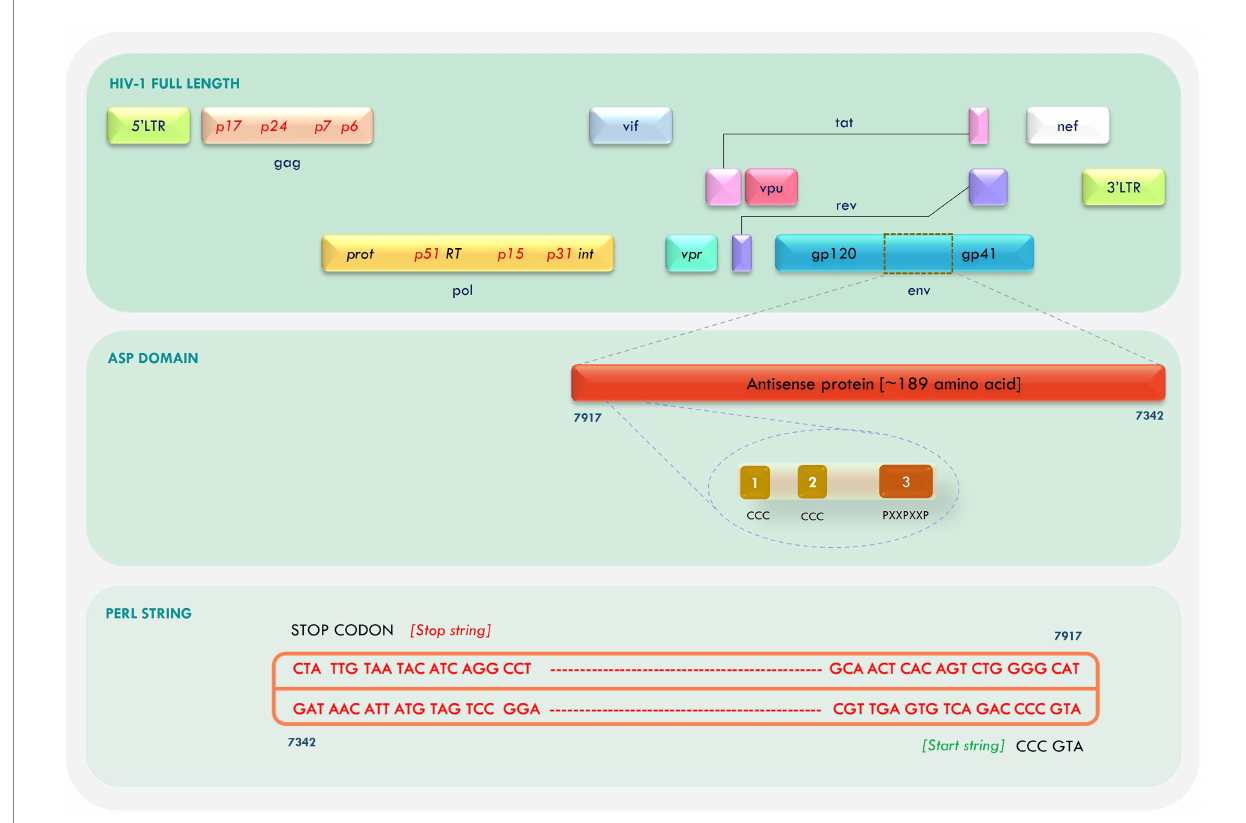
FIGURE 1 Mapping of antisense protein (ASP) in the Human Immunodeficiency Virus-1 (HIV-1) genome and retrieval of open reading frame (ORF).